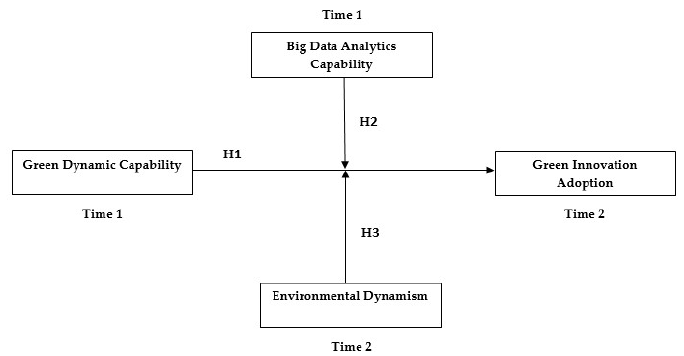
Figure 1. Research